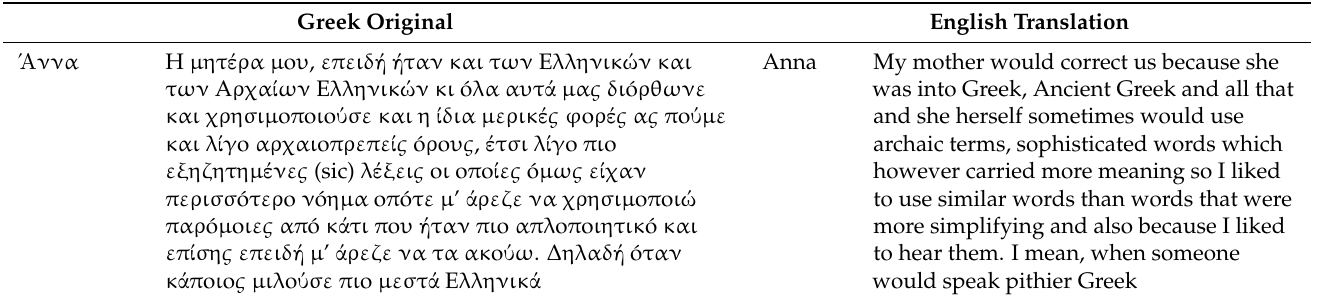
Table 8. “My mother was into Greek and Ancient